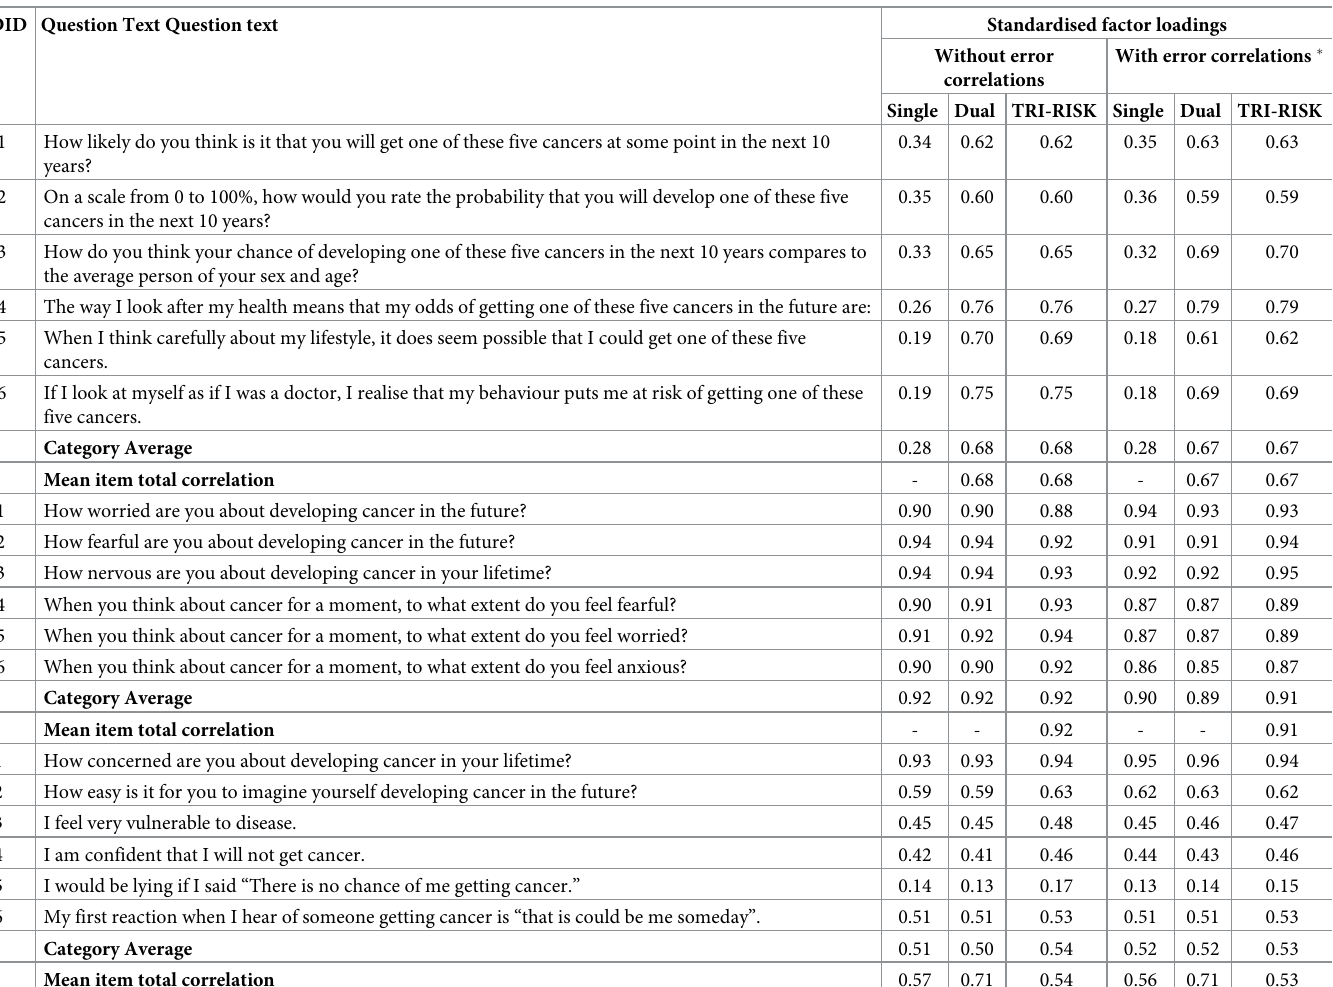
Table 3. CFA results for the single, dual and TRIRISK